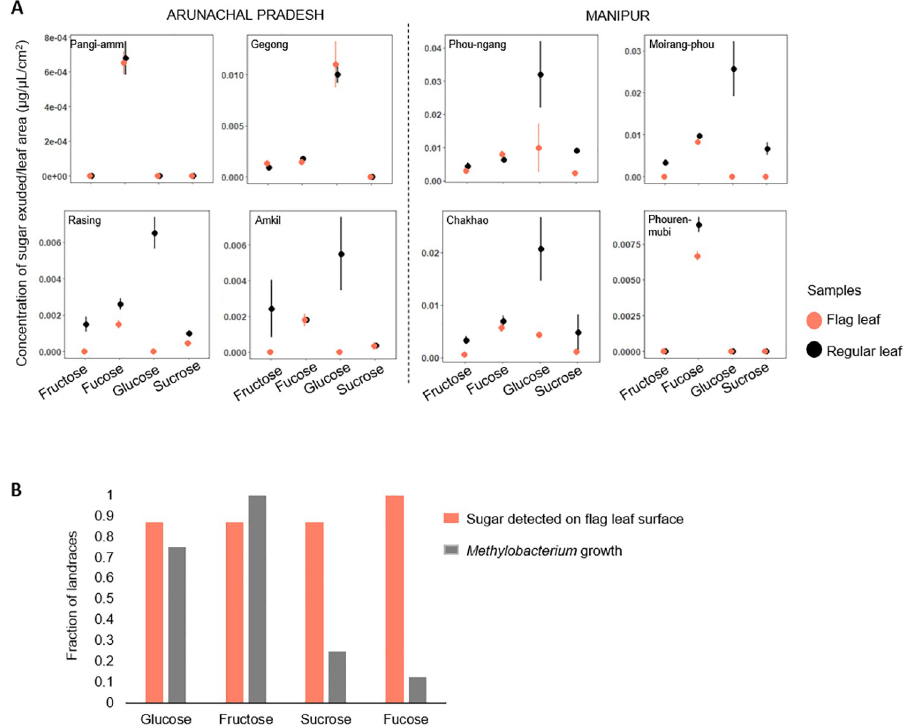
Fig 8. Sugar availability on rice leaf surface does not explain carbon use profiles of Methylobacterium isolates. (A) Plots show the mean concentration ( ± SE) of sugars detected on rice leaf surfaces of focal landraces from Arunachal Pradesh and Manipur (n = 3 samples / leaf type / landrace. (B) Bar plot shows the proportion of landraces that produce a specific sugar, and the ability of associated Methylobacterium strains to use each sugar.